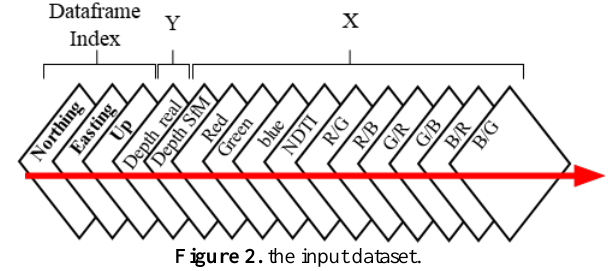
Figure 2. the input